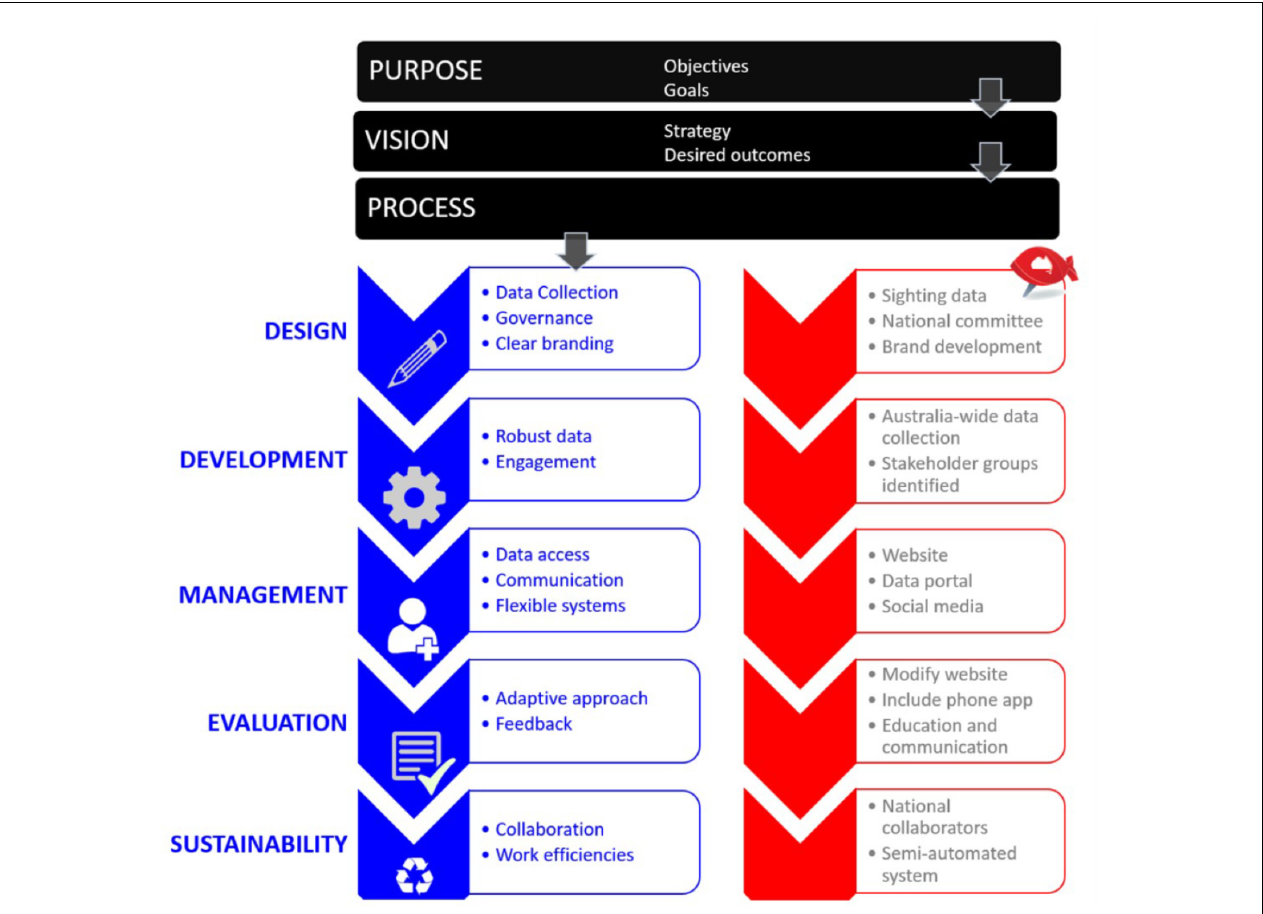
FIGURE 2 | The objectives and goals of Redmap have determined the project strategy and the desired outcomes, which in turn have defined the approaches taken (right in red) to address the key challenges associated with development and maintenance of Redmap as a successful large-scale long-term citizen science project (left in